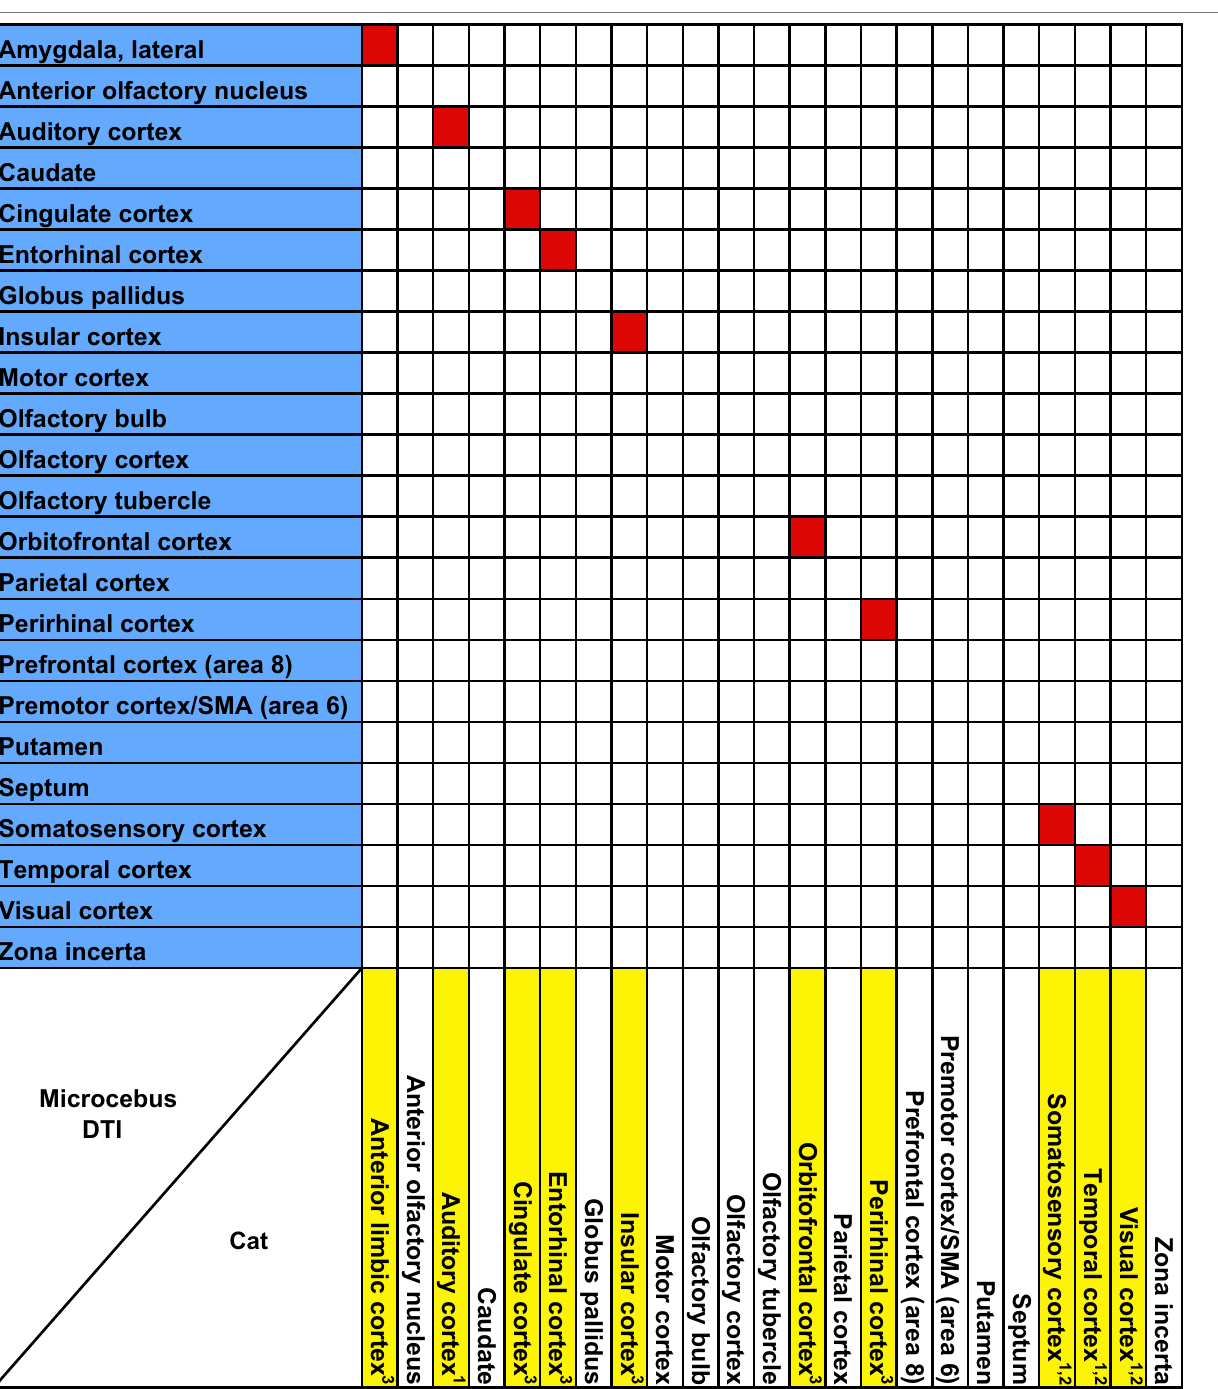
Table 1 | Comparison of claustral connectivity in the cat and the Microcebus .